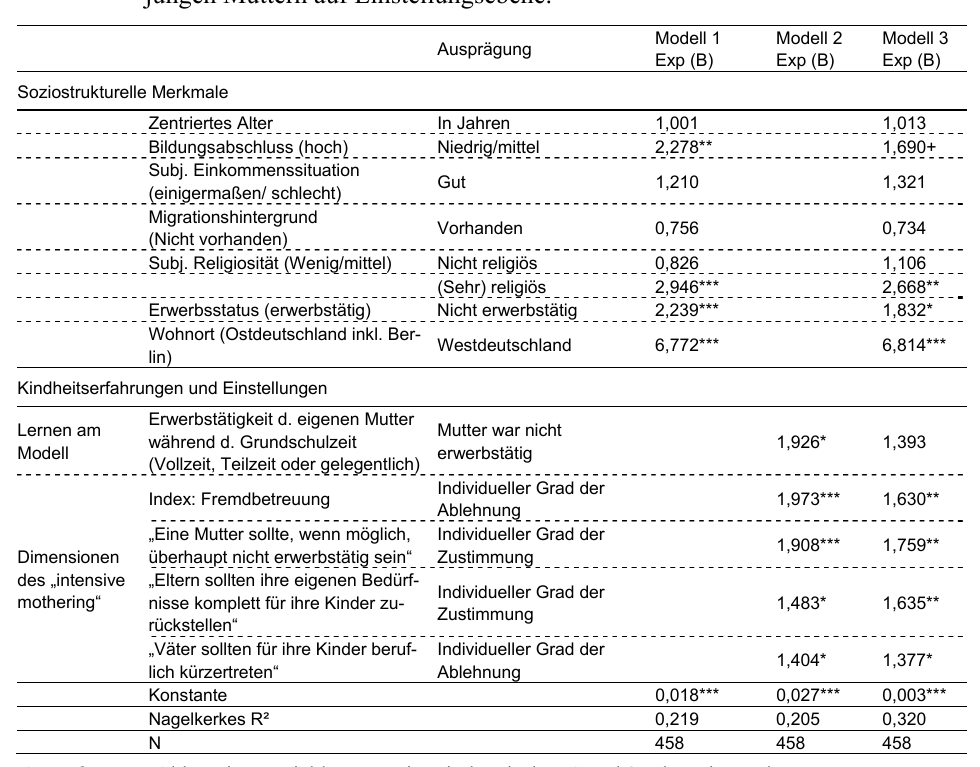
Tabelle 1: Soziostrukturelle und kulturelle Einflussgrößen des „intensive mothering“ bei jungen Müttern auf